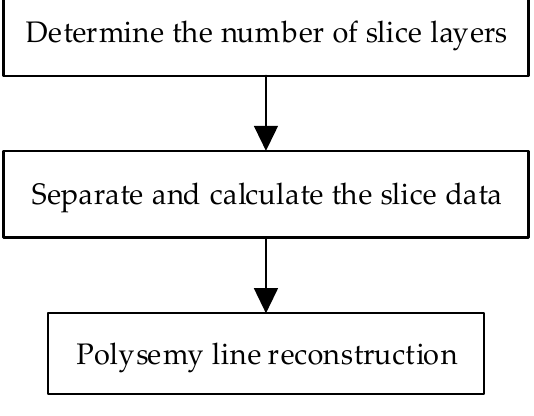
Figure 1. Point cloud slicing